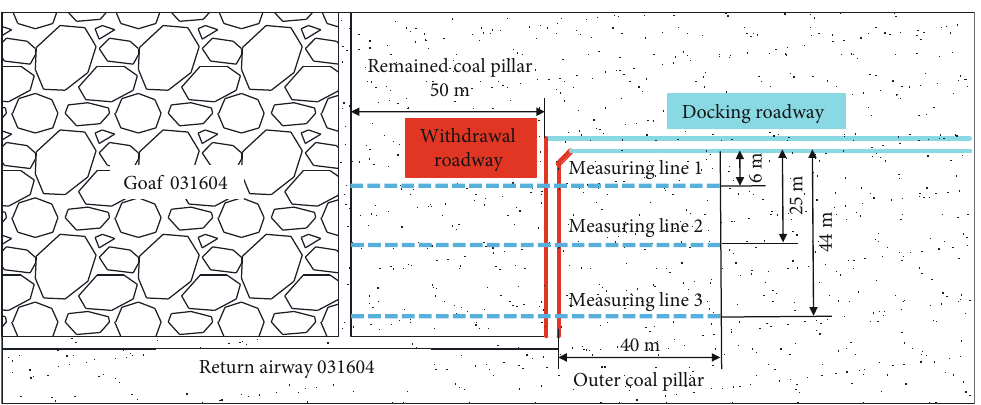
Figure 8: Monitoring position of mine